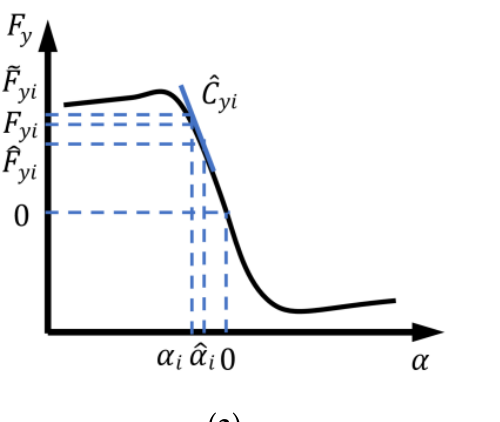
( b ) the lateral tire force at ˆ κ i . 𝑖